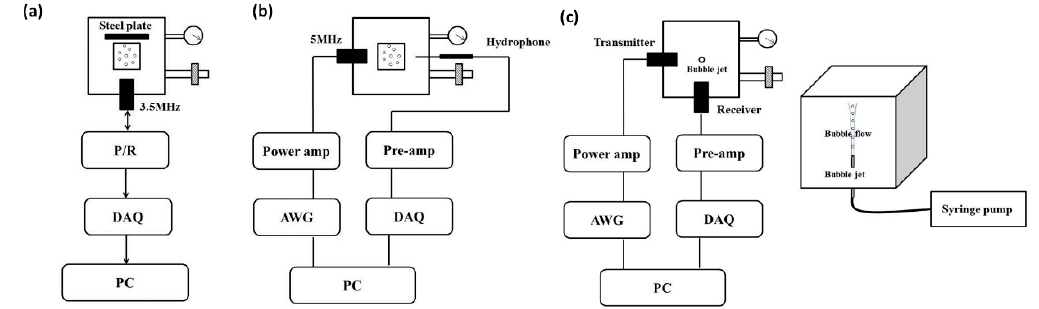
Figure 2. Schemes of the experimental setups for measurements of microbubbles’ acoustic properties in an ambient pressure range of 4–180 mmHg and at different time (<35 min) after injecting microbubbles. ( a ) Attenuation measurements; ( b ) Acoustic transmission measurement; ( c ) Scattering measurements and the bubble flow injection system in the 8 − 180 mmHg ambient pressure range. For the setup, ( a ) the Pulser/Receiver (P/R) generated and received pulses. For the setup, ( b ) the arbitrary waveform generator (AWG) connected to the power amplifier (Power amp) generated tone bursts and the transmitted signals from microbubbles were received, amplified, and digitalized by the data acquisition card (DAQ). Furthermore, the signal processing was executed by a personal computer. For ( a ) and ( b ), ultrasound contrast agents (UCA) microbubbles were added into a sample chamber. For the setup, ( c ) the diluted SonoVue microbubbles were pumped into the water tank by a syringe pump, and the bubble flow was located at the focus of the transducers. The ambient pressure was controlled by an air pump and monitored by a pressure sensor.